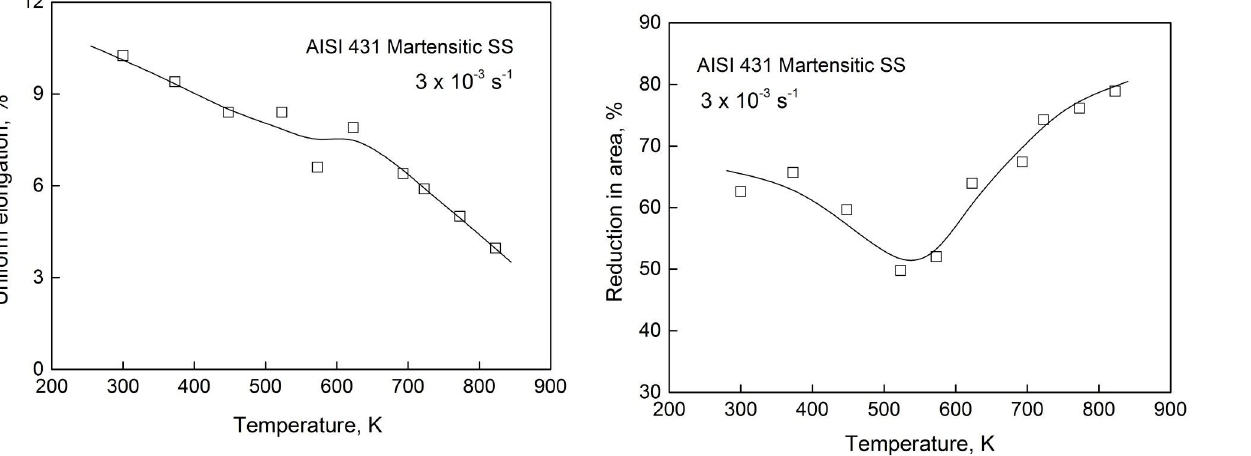
Figure 6: Variation of reduction in area with temperature for the AISI 431